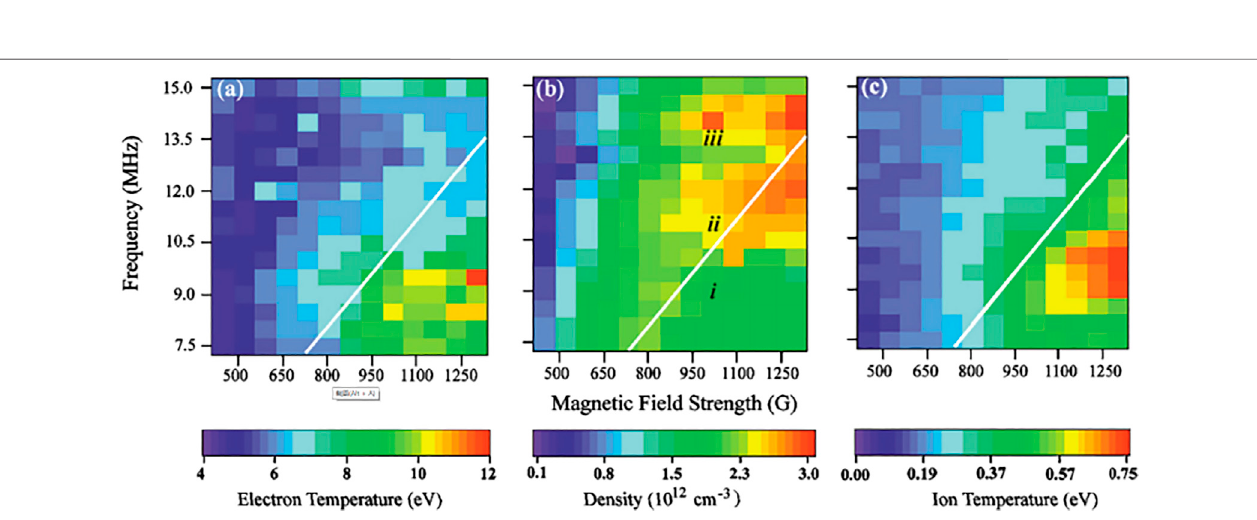
FIGURE 2 | Variations of electron temperature (A) , plasma density (B) , and ion temperature (C) with antenna frequency and magnetic fi eld strength. Reproduced from [17], with the permission of APS Publishing.